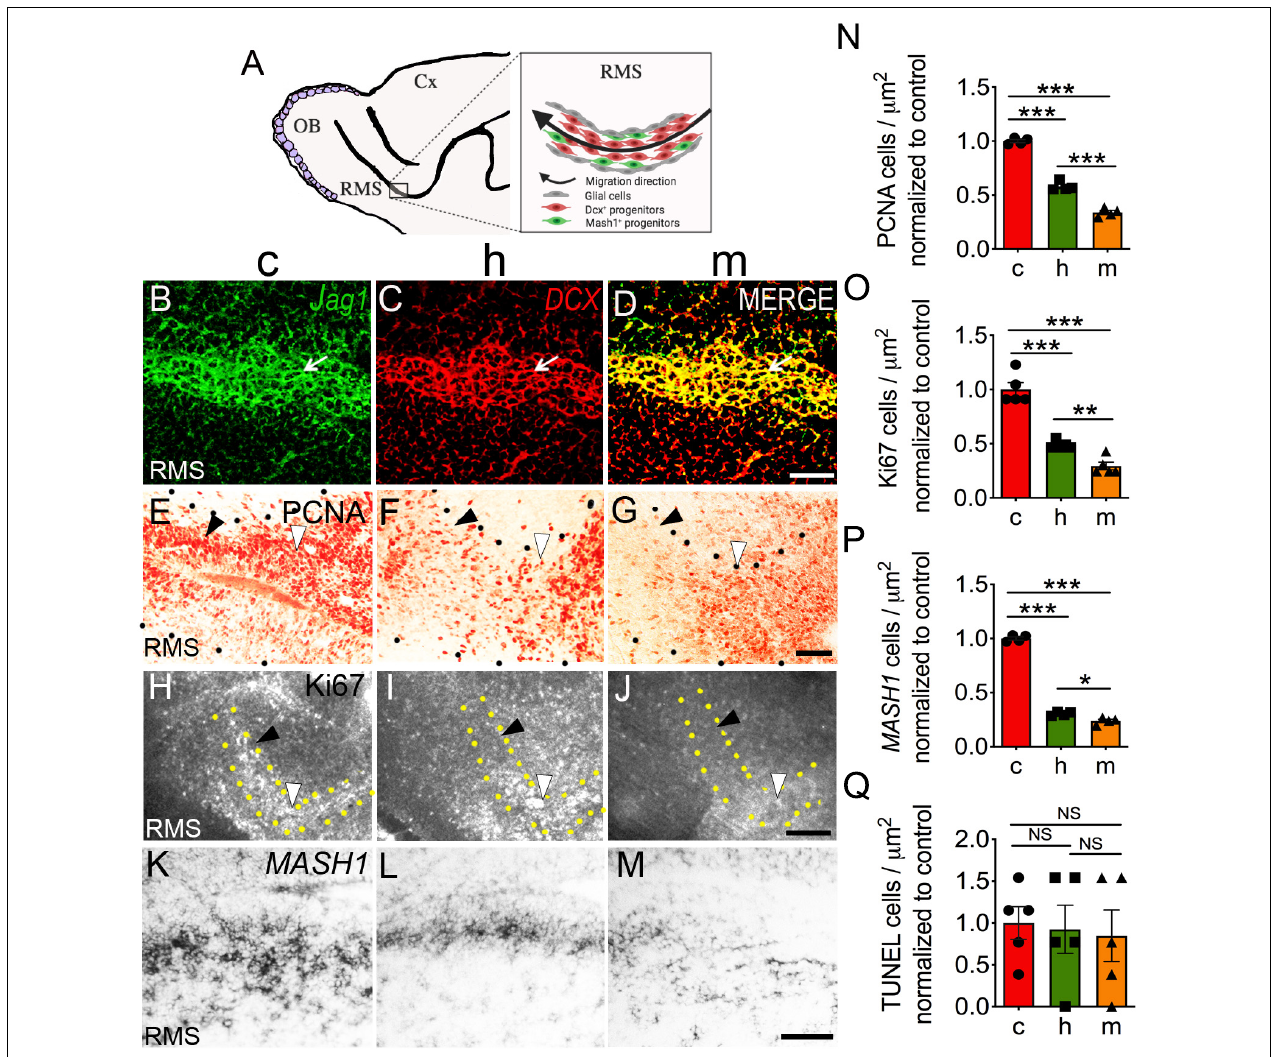
FIGURE 5 | Haploinsufficient in Jag1 causes defects in the rostral migratory stream. (A) Schematic illustration of the RMS. Double-labeled in situ hybridization on control brain sections using probes for (B) Jag1 (green) and (C) DCX (red) shows (D) coexpression (yellow) in the RMS (white arrows). Scale bar = 100 µ m. Immunohistochemistry using (E–G) anti-PCNA and (H–J) anti-Ki67 antibodies shows reduction in PCNA (c, n = 4; h, n = 4; m, n = 4) and Ki67 (c, n = 5; h, n = 5; m, n = 5) signals in (F,I) heterozygous and (G,J) homozygous mutants, respectively (black arrowheads). Scale bar = 50 µ m (PCNA) and 250 µ m (Ki67). (K–M) The number of Mash1 + cells decline in the heterozygous and homozygous mice (c, n = 4; h, n = 4; m, n = 4). Scale bar = 50 µ m. Graphs (N–P) display the quantification of PCNA, Ki67, and Mash1 . (Q) Total count of apoptotic cells using TUNEL shows no changes in cells death (c, n = 5; h, n = 5; m, n = 5). All images are sagittal brain sections at E17.5. White arrowheads indicate the elbow of the RMS. All graphs show average ± SEM. Key to statistics: * p < 0.05; ** p < 0.01; *** p < 0.001, respectively, in comparison to control or heterozygous; NS, not significant. A minimal of four independent embryos was counted for each genotype and one to two sections were selected from each genotype. RMS, rostral migratory stream; Cx,